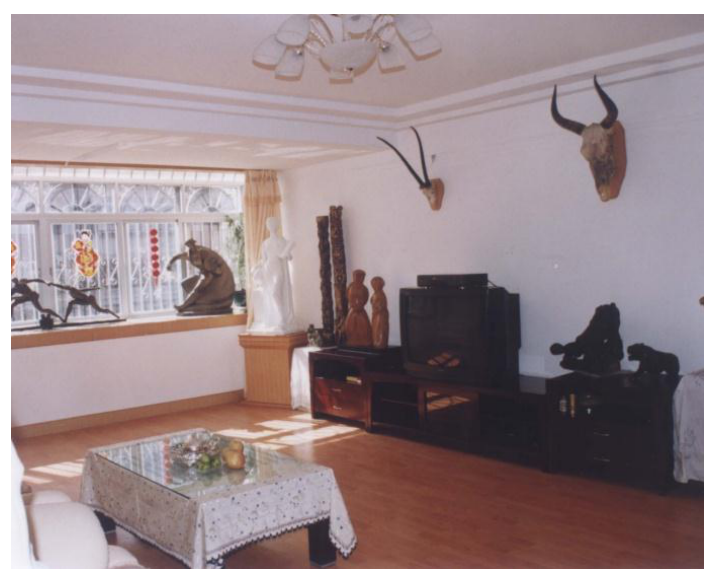
Figure 5. The balcony as part of the living